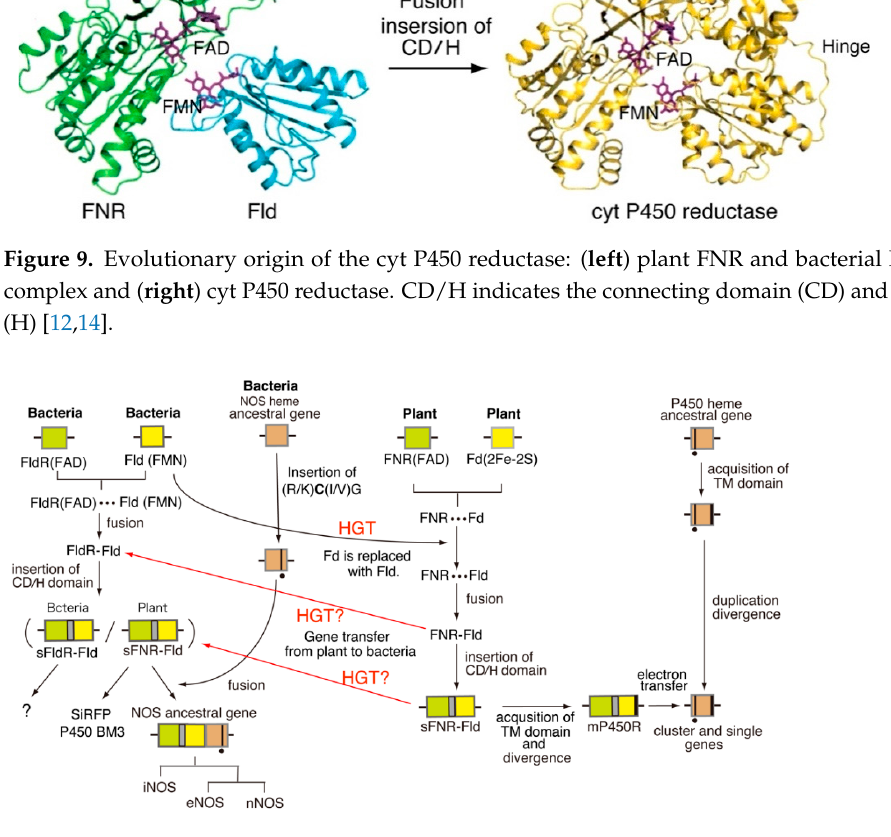
Figure 10. Evolutionary model of the formation of the diflavin reductase family. All domains are arranged in order of the C-terminus (left) to the N-terminus (right), and the FNR (FAD) domain is positioned on the left. FNR-Fd indicates a fusion gene composed of FNR and Fld. sFNR-Fld indicates soluble ancestral FNR-Fld reductase. mP450R, membrane-bound cyt P450 reductase; FldR, flavodoxin reductase; SiFP, bacteria sulfite reductase flavoprotein component; P450BM3, cytochrome P450BM3 from Bacillus megaterium . For cyt 450 reductase and NOS isoforms, a dot indicates the conserved proximal cysteine residue, where the heme domains for the bacterial and mammalian NOS isoforms share a sequence motif, (R/K) C (I/V) G in the conserved proximal cysteine residues, which is found in cyt P450 gene family 1 [14]. The CD/H indicates the connecting (C) and hinge (H) domains (gray). TM indicates the membrane-binding domain. The electron transfer occurs from the electron donor NAD(P)H to the final electron acceptor heme iron: NAD(P)H → FAD → FMN/or [2Fe-2S] → Heme iron. HGT (red) indicates the transfer of the bacterial Fld gene to plant cells. HGT? (red) indicates the transfer of the plant FNR-Fld or sFNR-Fld gene to bacterial cells. Thus, the FAD-FMN module of bacterial SiR and P450BM3, mammalian cyt P450 reductase and NOS isoforms are derived from plant FNR-Fld or sFNR-Fld as a precursor gene [14,21].